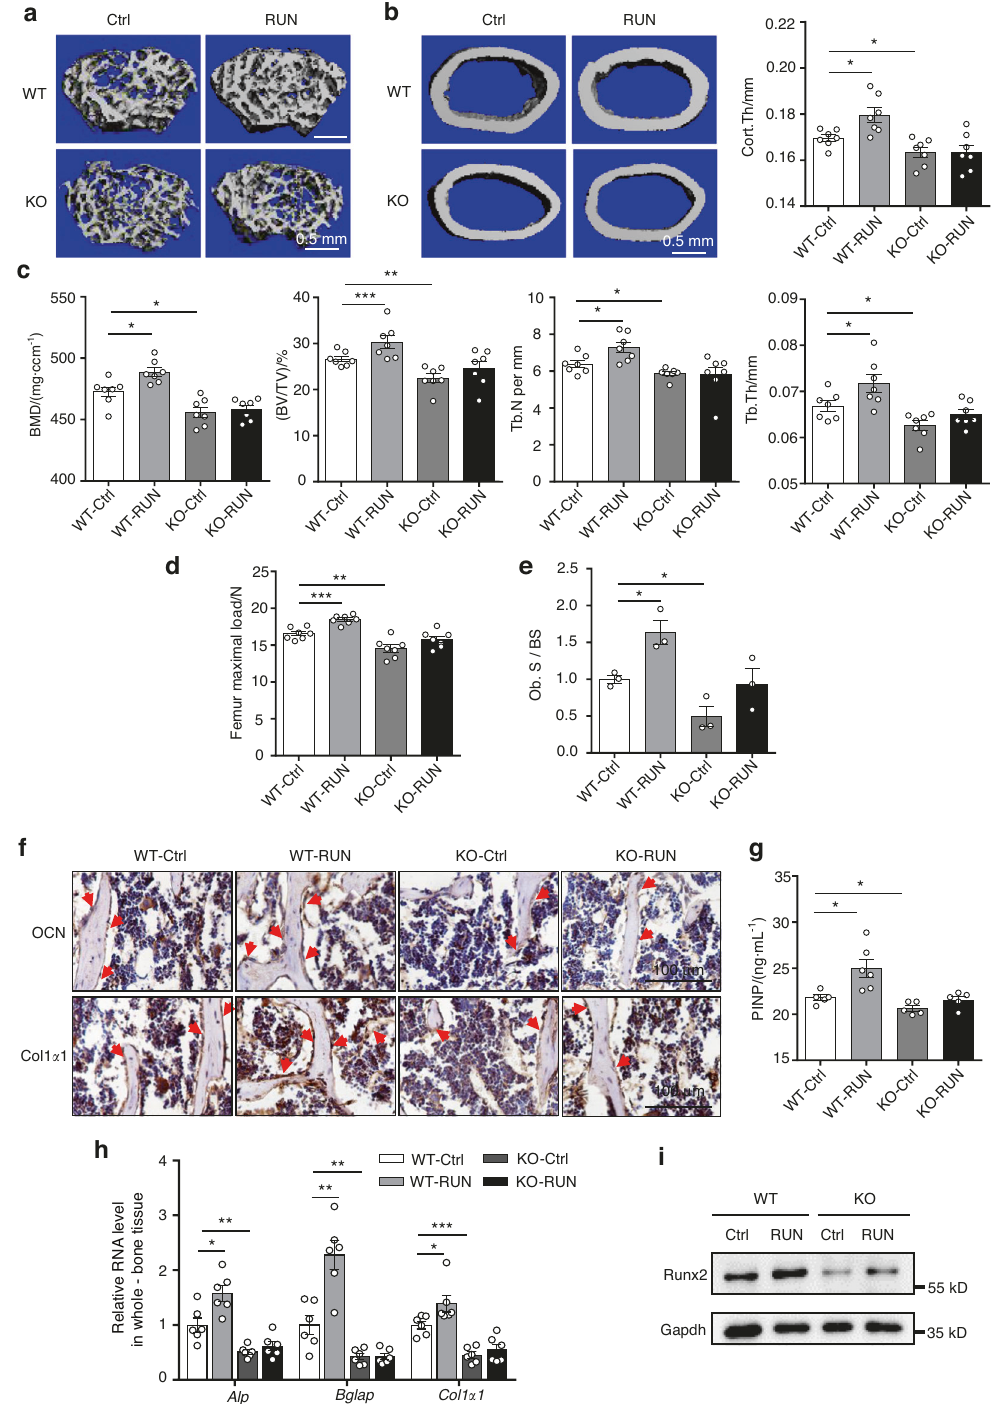
Fig. 6 The effect of mechanical loading on the bone was signi fi cantly weakened in the Neat1 knockout mice. a , b Representative 3D μ -CT images showing trabecular and cortical bones from distal femurs of the indicated mice. Scale bars, 0.5 mm. Cortical bone thickness of distal femurs from the control and mechanically loaded mice was analyzed. n = 7 in each group. c Quantitative µ-CT analysis of BMD, BV/TV, Tb.N and Tb.Th from 17-week-old WT and Neat1 -KO mice. n = 7 in each group. d Femur maximal load determined by three-point bending of 17-week-old WT and Neat1 -KO mice of the indicated groups. n = 7 in each group. e Histomorphometric analysis of osteoblast surface per bone surface in the WT and Neat1 -KO mice with or without mechanical loading. n = 3 in each group. f Immunohistochemical staining of OCN and Col1 α 1 in tibial sections from 17-week-old Neat1 -KO and control mice with or without mechanical loading. Scale bars, 100 μ m. g ELISAs of serum PINP (ng·mL − 1 ) in the control and Neat1 -KO mice with or without mechanical loading. n = 5 or 6 in each group. h Osteogenic gene expression in whole-bone tissue from the WT and Neat1 -KO mice with or without mechanical loading. n = 6 in each group. i Immunoblot analysis of Runx2 protein levels in whole-bone tissue from the WT and Neat1 -KO mice with or without mechanical loading. Representative results of three independent experiments are shown. * P < 0.05, ** P < 0.01, *** P <